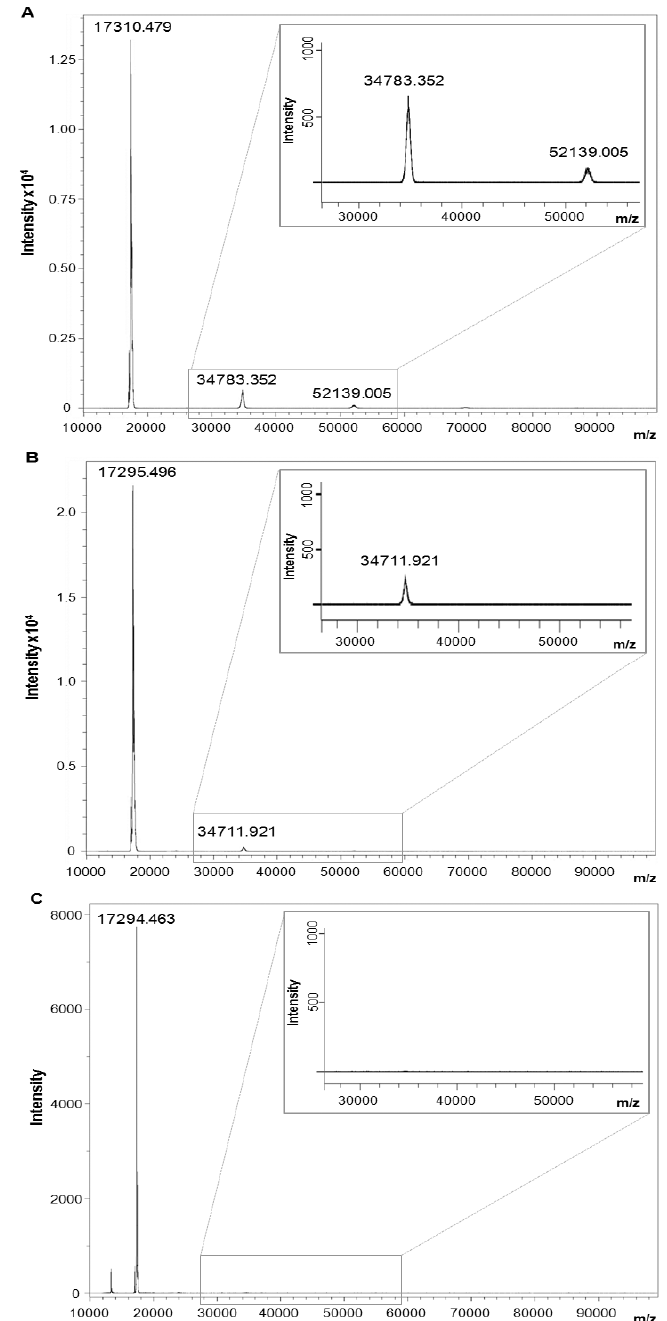
Figure 6. Evaluation of hTNF- α dissociation by MS. MS analysis of hTNF- α alone ( A ) or incubated with tetra-branched anti-TNF- α peptide used in a 3-fold ( B ) or 10-fold ( C ) molar excess with respect with hTNF- α . MWs are indicated over every peak. Panel A shows peaks around 17,300, 34,700 and 52,100 Da, corresponding to monomeric, homodimeric and homotrimeric forms of hTNF- α , respectively. When the concentration of anti-TNF- α peptide was increased, the peaks of trimeric and dimeric hTNF- α disappeared (B and C, respectively). The graph portion of dimeric and trimeric hTNF- α is magnified in each panel. The high intensity of monomeric TNF- α peak was the result of homo-trimer dissociation caused by laser energy generated during sample desorption. The small peak present approximately at 13,000 Da in panel C corresponds to a peptide dimer (monomer MW